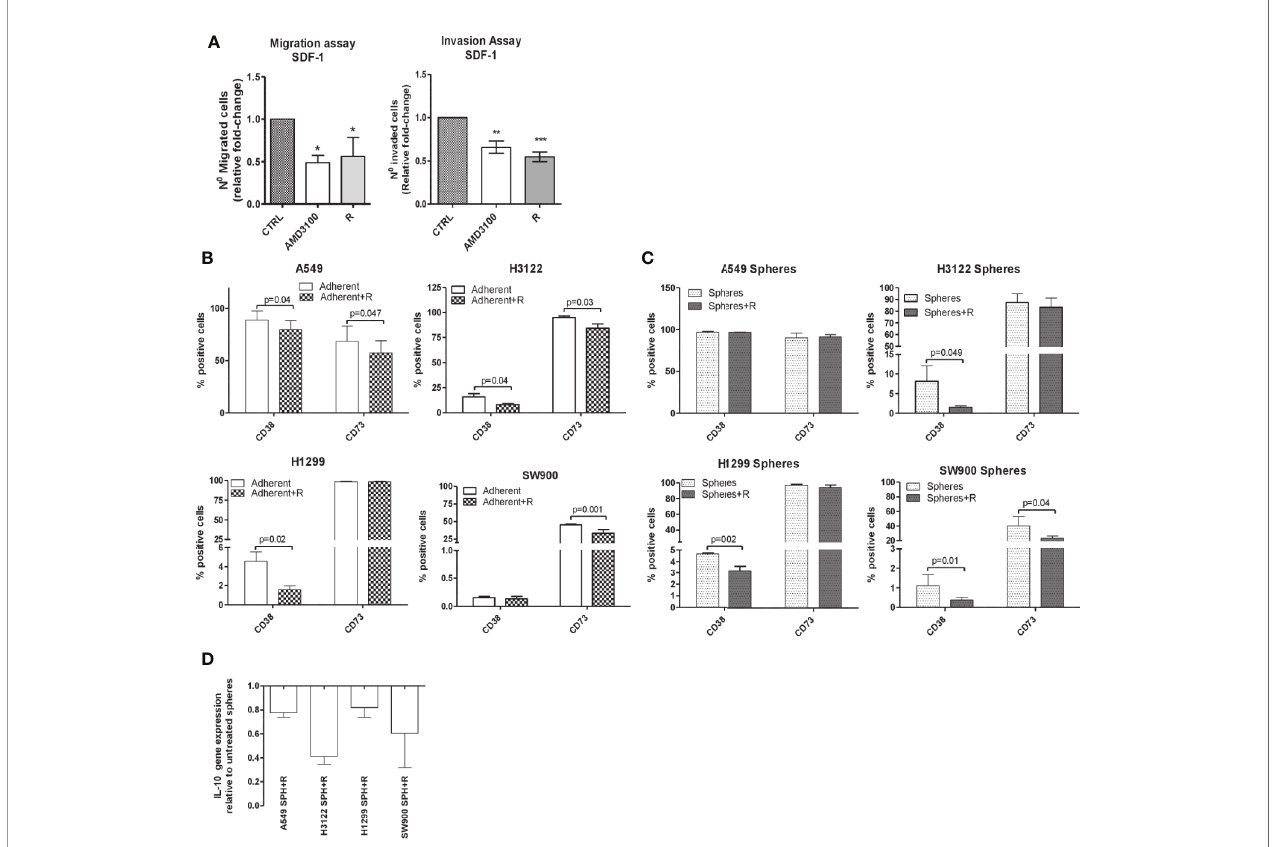
FIGURE 3 | Inhibition of CXCR4 axis prevents MICs migration and decreases immunomodulatory marker expression. (A) Migration and invasion assay performed in vitro on A549, H3122, H1299 cell lines. Cells were treated with CXCR4 inhibitors: peptide R 1µM or AMD3100 10 µM and chemoattracted by SDF-1 50 ng/ml. Data represent the median fold change of number of migrated/invaded cells after treatment relative to untreated control. Duplicate experiments were performed for each cell line *p < 0.05. **p < 0.01. ***p < 0.001 (B) FACS analysis of adherent cells and (C) lung spheroids for the expression of CD38 and CD73 markers 2 h after treatment with peptide. Data are the mean value ± SD of n=3 analyses for each cell line. (D) Real-Time PCR quanti fi cation of IL-10 gene expression in spheroids after treatment with CXCR4 inhibitor compared to untreated